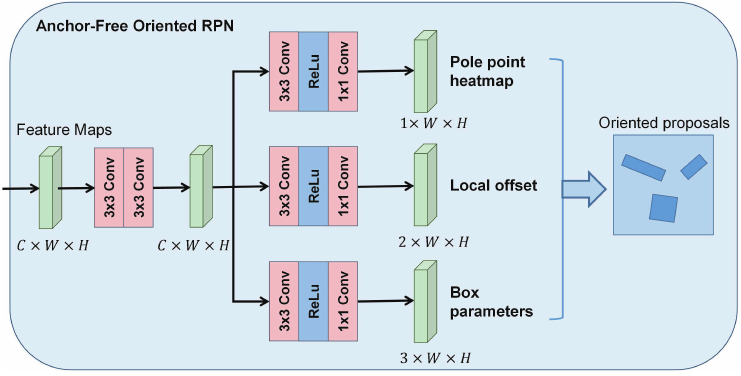
Figure 4. Details of the proposed AFO-RPN.